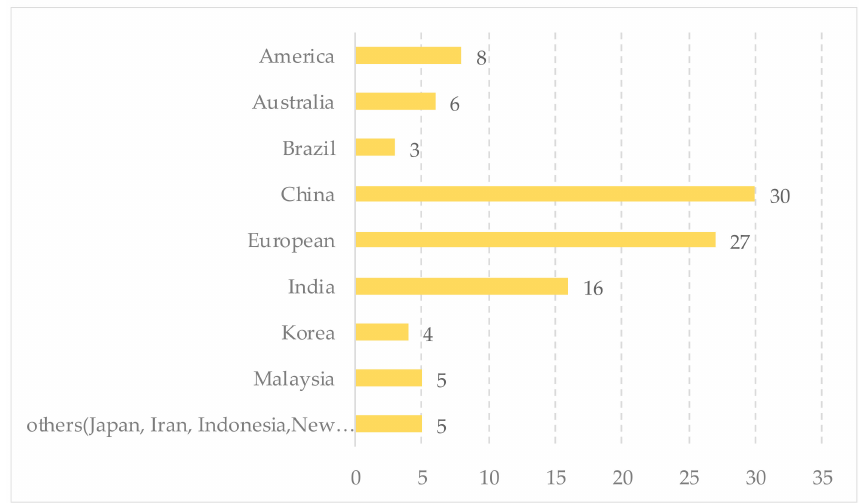
Figure A1. Distribution of papers across